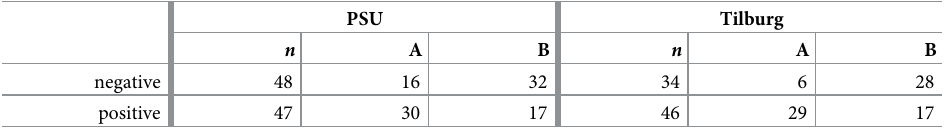
Table 5. The secured relevance is Rls = 4.16 ( z = 10% ℓ ) and 10.1 ( z = 10% ℓ ) for the two institu-